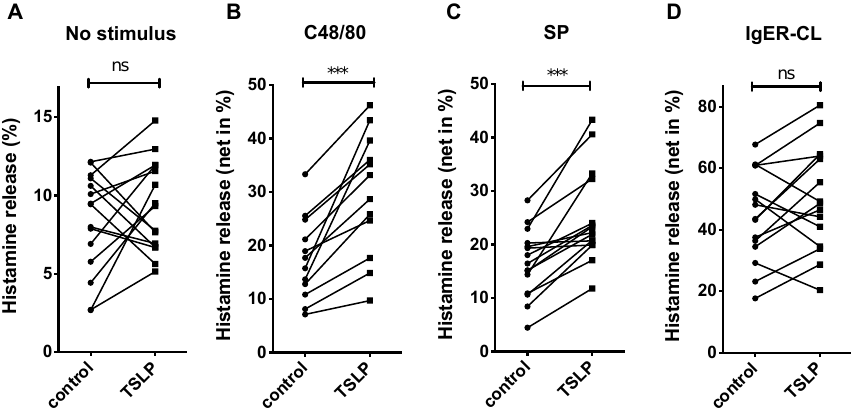
Figure 1. Thymic stromal lymphopoietin (TSLP) priming selectively promotes MRGPRX2-mediated histamine release in human skin mast cells (MCs). Skin-derived MCs were pre-stimulated with TSLP (7.5 ng/mL) or vehicle (control) for 30 min prior to stimulation. Histamine release was assessed 30 min after treatment with ( A ) no stimulus; ( B ) c48/80 (10 µ g/mL); ( C ) Substance P (SP) (30 µ M); ( D ) IgER-CL (IgER-crosslinking; AER-37, 0.2 µ g/mL). B–D show the net histamine release, i.e., stimulated release–spontaneous release (in % of total histamine). MCs from the same preparation are shown as interconnected dots (n = 12–15), *** p < 0.001, ns, not significant. Collectively, TSLP selectively promotes MRGPRX2-driven degranulation of human skin